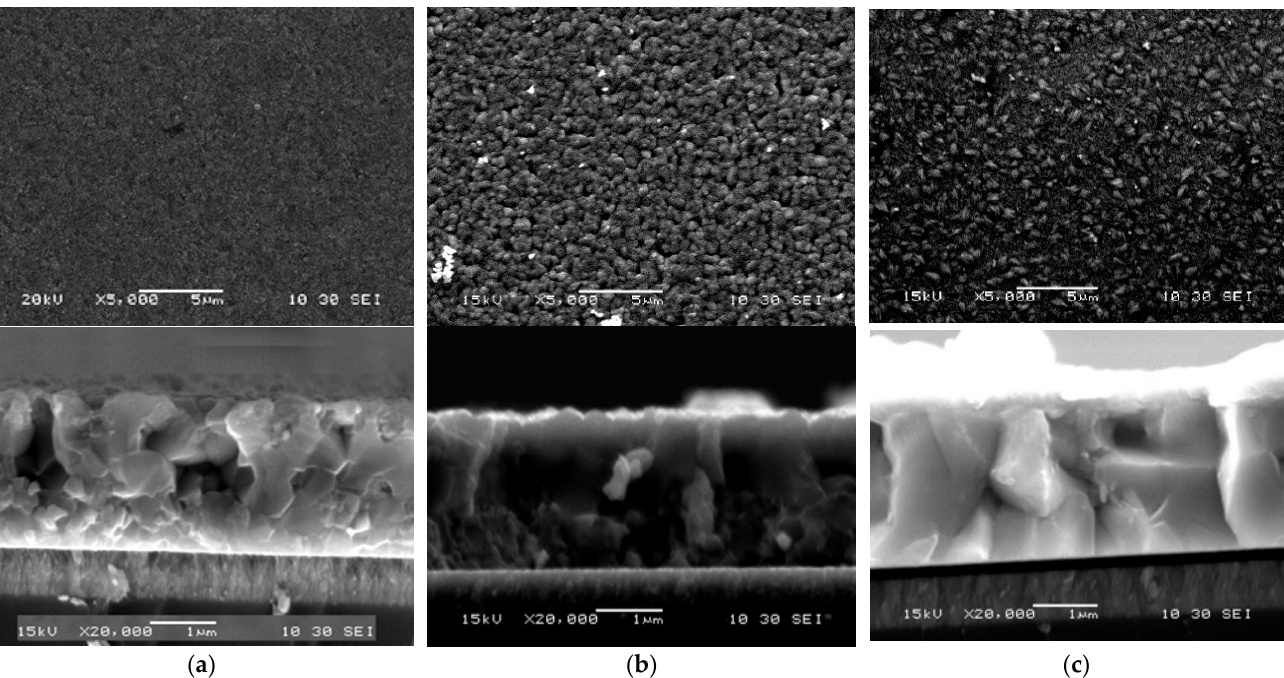
Figure 5. Scanning Electron Microscopy photographs of the CIGS films: reference ( a ), third stage LT ( b ) and third stage HT ( c ) recrystallized in a CuCl 2 environment.